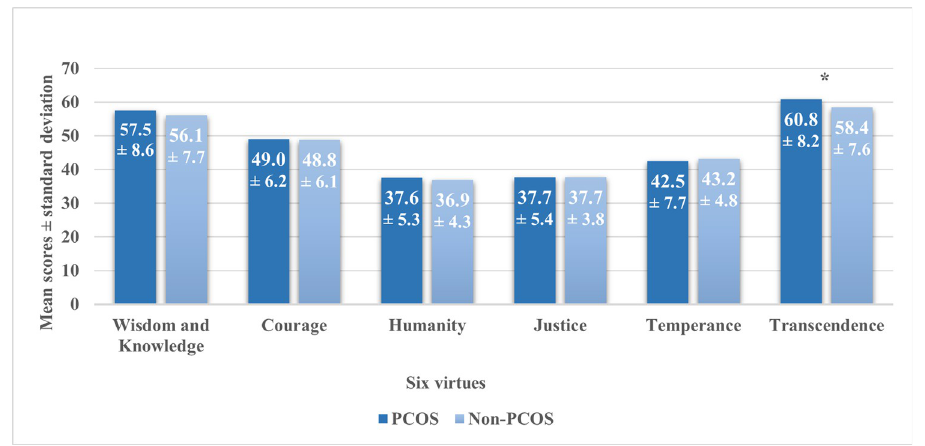
Fig 1. Comparison of 6 virtues between the two groups [PCOS (n = 49); non-PCOS (n = 50)]. � : indicates significance (p-value < 0.05).